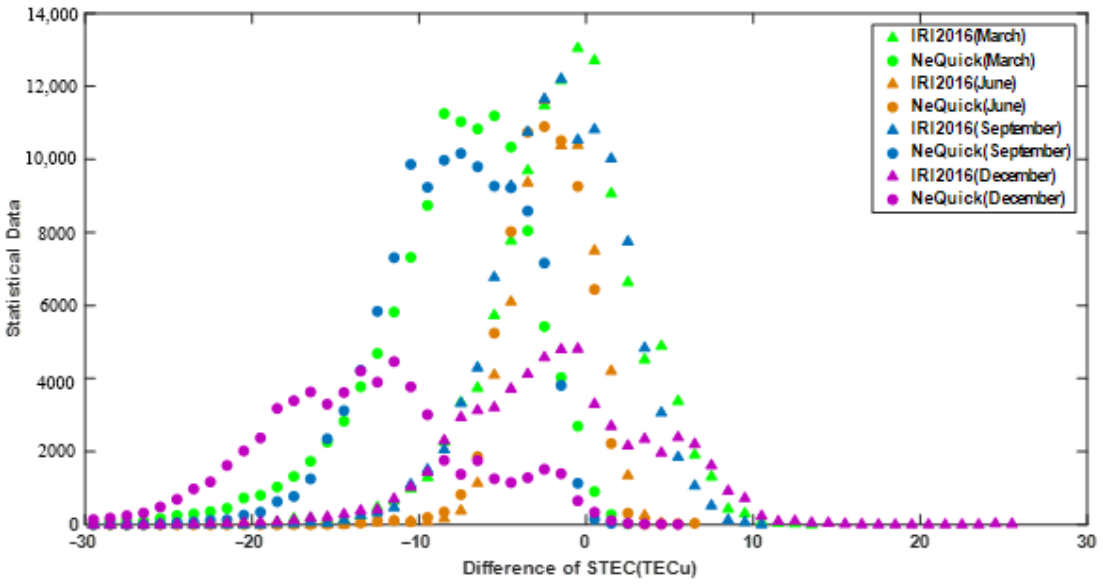
Figure 7. Distribution interval statistics of dSTEC of the IRI-2016 and NeQuick2 models.